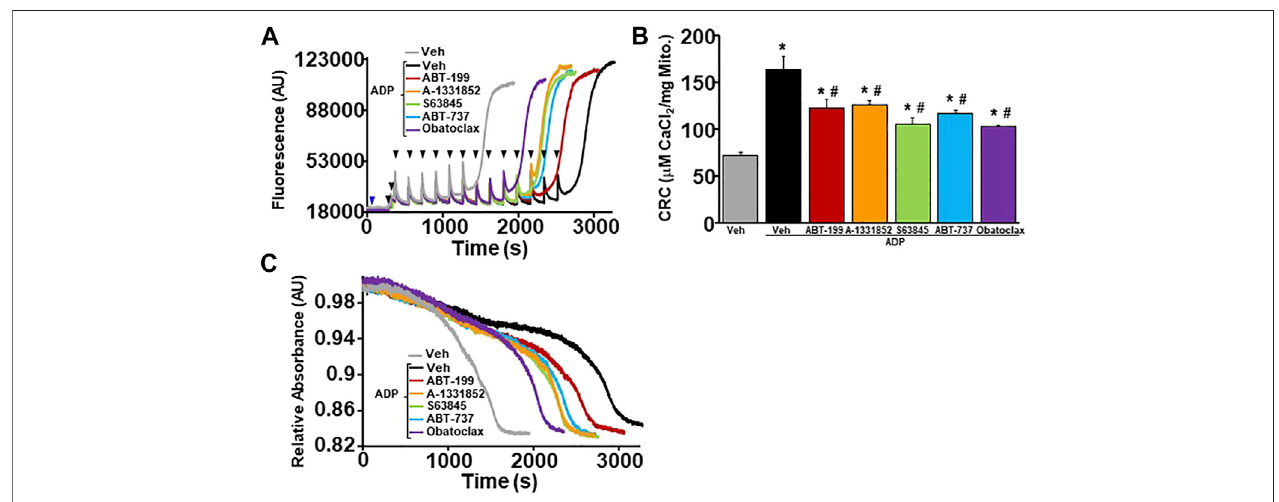
FIGURE 4 | BH3 mimetics reduced mitochondrial CRC and sensitize MPTP opening in the presence of ADP. (A) Representative traces of mitochondrial calcium uptakeofWTlivermitochondriapre-treatedwith300 µMadenosinediphosphate(ADP)andthenwitheither200 nMABT-199(red),100 nMA-1331852(orange),10 nM S63845(green),100 nMABT-737(blue),10 nMObatoclax(purple),orwiththevehiclecontrol(black).ControlWTlivermitochondriawithoutADPpretreatmentisshown in grey. The blue arrow represents the addition of the BH3 mimetics. The black arrowheads represent the addition of 20 μ M CaCl 2. (B) Quanti fi cation of mitochondrial calcium retention capacity (CRC) calculated from mitochondrial calcium uptake traces, as in (A) . (C) Representative trace of corresponding mitochondrial swellingto (A) ofWTlivermitochondria pre-treated withADPand thentreatedwithBH3mimeticsandCaCl 2 .Threeindependent experiments ( n (cid:2) 3)wereperformedfor every panel. * p ≤ 0.05 for comparison the Veh. # p ≤ 0.05 for comparison the Veh w/ADP.